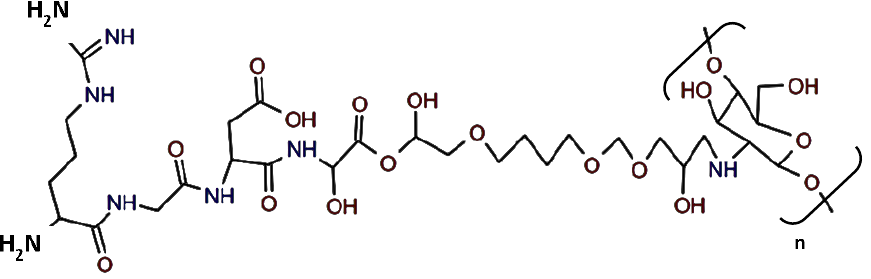
Figure 1. Chemical structure of the RGD−Chitosan conjugate.